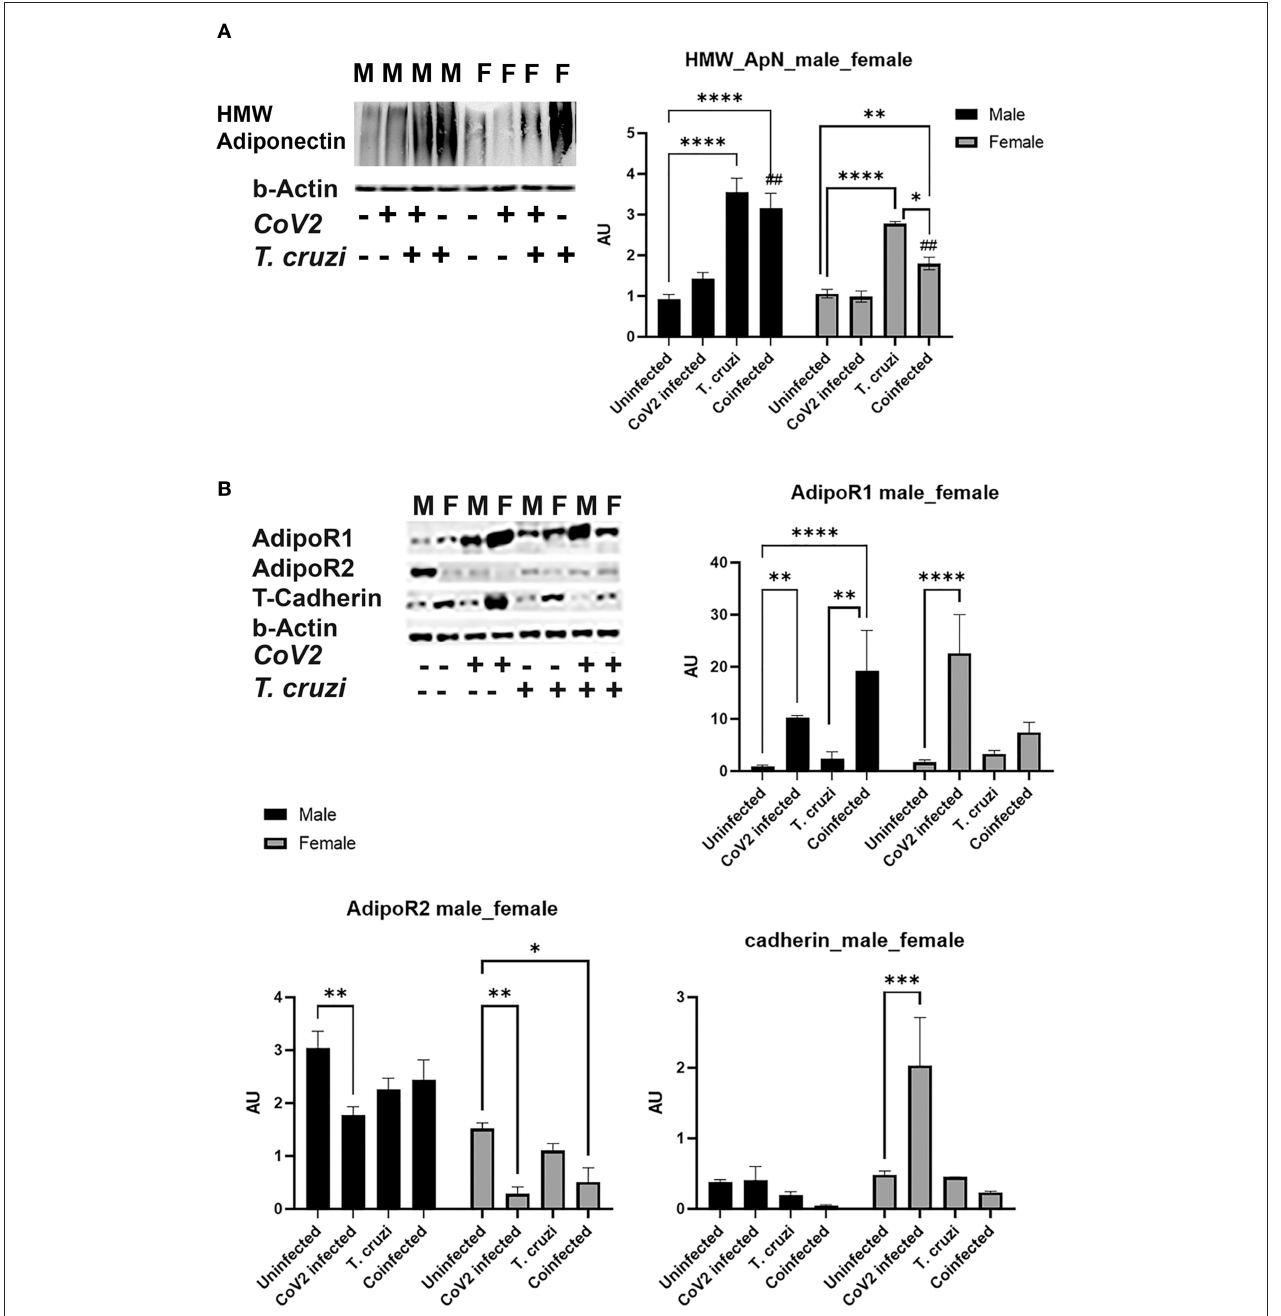
FIGURE 5 | Immunoblot analysis of adipogenic markers in the hearts of Cov2 infected, T. cruzi infected, and coinfected huACE2 mice. Western blot images of (A) cardiac high-molecular weight adiponectin (HMW ApN) and (B) ApN receptors (Adipo R1, R2 and T-cadherin). β -Actin was used as loading control. Fold-changes in the protein levels of adipogenic markers normalized to β -Actin are shown as bar graphs. (A dot plot displaying individual data point is shown in Supplementary Figure 4 ). The error bars represent standard error of the mean. * p < 0.05, ** p < 0.01, *** p < 0.001 and **** p < 0.0001 compared to uninfected sex matched mice ( n = 4/sex/group) ( ## p ≤ 0.01 for comparisons between CoV2 infected and coinfected mice) (M, male; F, female).